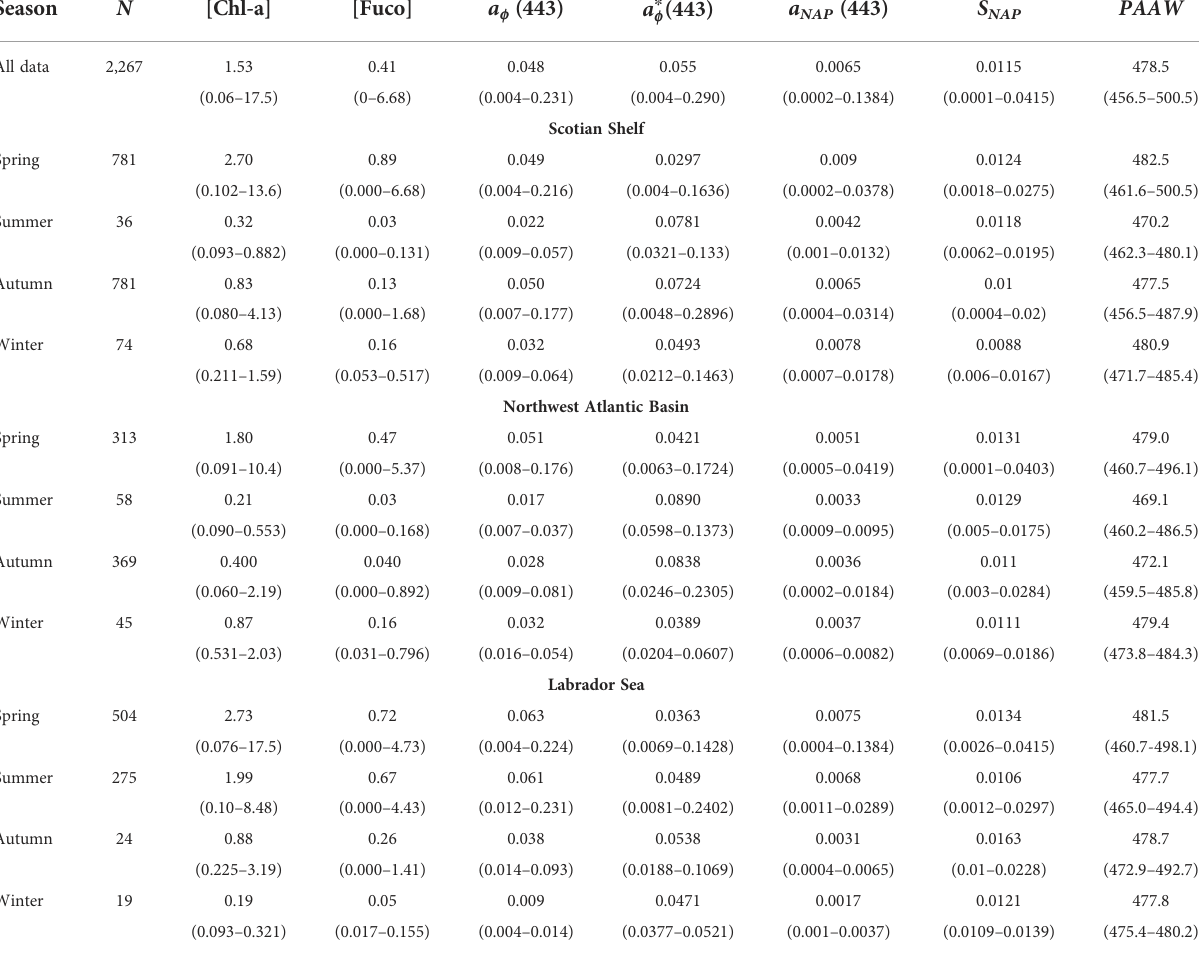
TABLE 1 Mean values and range of variations (min – max) of [Chl-a], [Fucox], a f (443), a f (443)